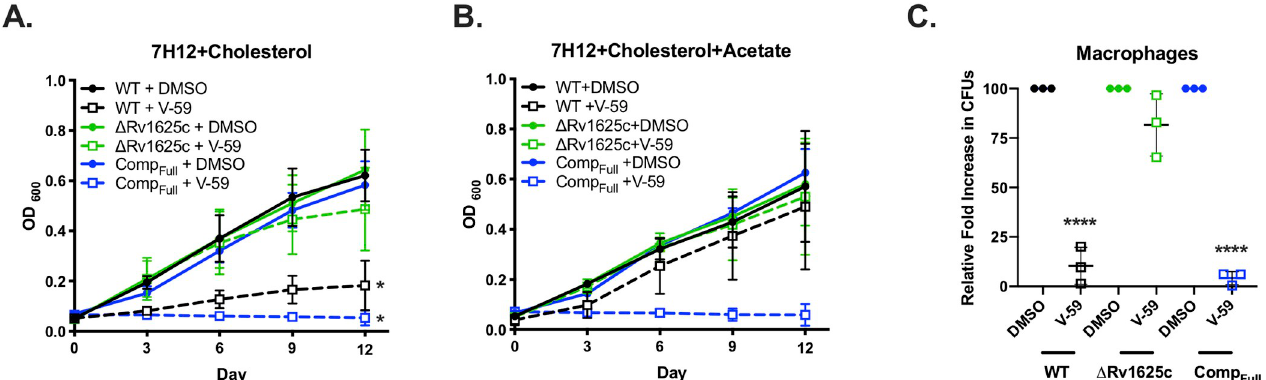
Fig 1. V-59 inhibits Mtb growth in an Rv1625c-dependent mechanism. ( A and B ) Impact of V-59 on Mtb growth in cholesterol media ( A ) and in media containing cholesterol and acetate ( B ). V-59 (10 μ M) was added to the cultures every three days, and DMSO is the vehicle control. Data are from two experiments, with three technical replicates each ( � P < 0.05, One-way ANOVA with Sidak’s multiple comparisons test). ( C ) Effect of V-59 on growth of Mtb in murine macrophages. Macrophages were infected at an MOI of 2 and treated with V-59 (25 μ M) or DMSO. Data are from three experiments with two or more technical replicates each ( ���� P < 0.0001, One-way ANOVA with Sidak’s multiple comparisons test on fold-change in CFU’s normalized to DMSO). All data are means ± SD.